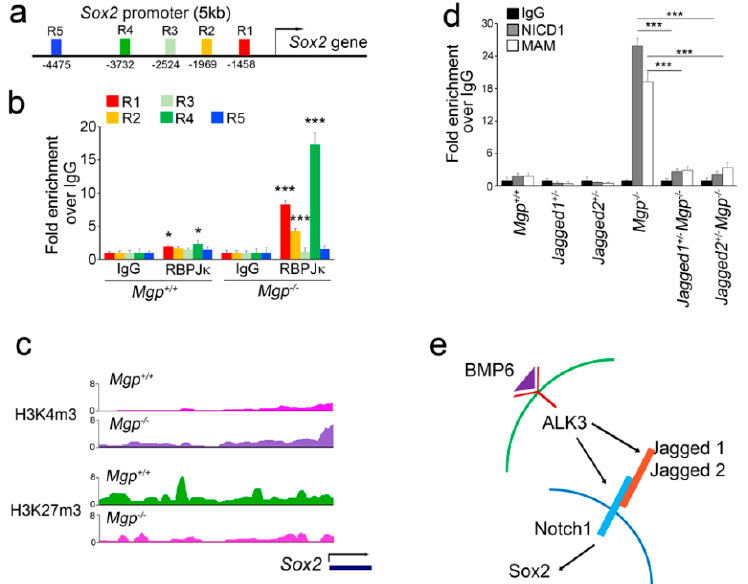
Figure 5. Notch signaling alters the regulatory complex in the Sox2 promoter to activate its expression in Mgp - / - cerebral ECs. ( a ) Recombination signal binding protein for immunoglobulin kappa J (RBPJ κ ) binding (R) sites in + 5 kb upstream of the regulatory region of the Sox2 gene. ( b ) Chromatin immunoprecipitation (ChIP) assays demonstrating increased RBPJ κ binding in the Sox2 regulatory region in Mgp − / − cerebral ECs. ( c ) ChIP-seq data demonstrating the occupation of the bivalent marks trimethylated histone H3 lysine 4 (H3K4me3) and trimethylated histone H3 lysine 27 (H3K27me3) around the Sox2 gene locus in Mgp +/+ and Mgp − / − cerebral ECs. ( d ) ChIP assays demonstrating the increased binding of NICD1 and mastermind (MAM) around RBPJ κ binding site 4 in the Sox2 regulatory region of Mgp − / − cerebral ECs and the abolished binding in Jagged1 +/ − Mgp − / − and Jagged2 +/ − Mgp − / − cerebral ECs. * p < 0.05; *** p < 0.001. ( e ) Schematic diagram.